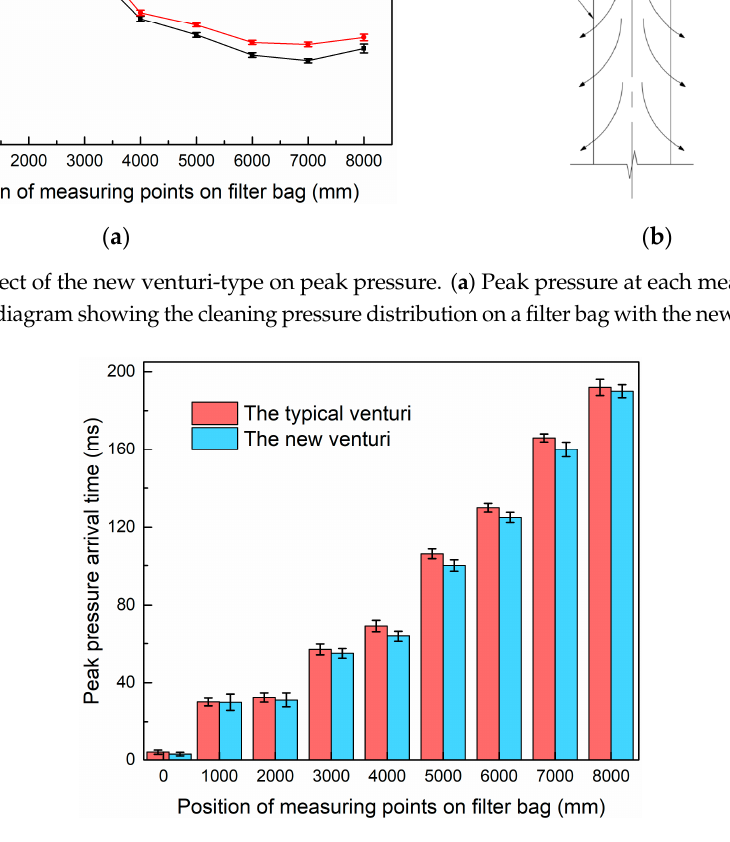
Figure 14. Peak pressure arrival time measured in different points of the filter bag adapted with the new venturi tube.